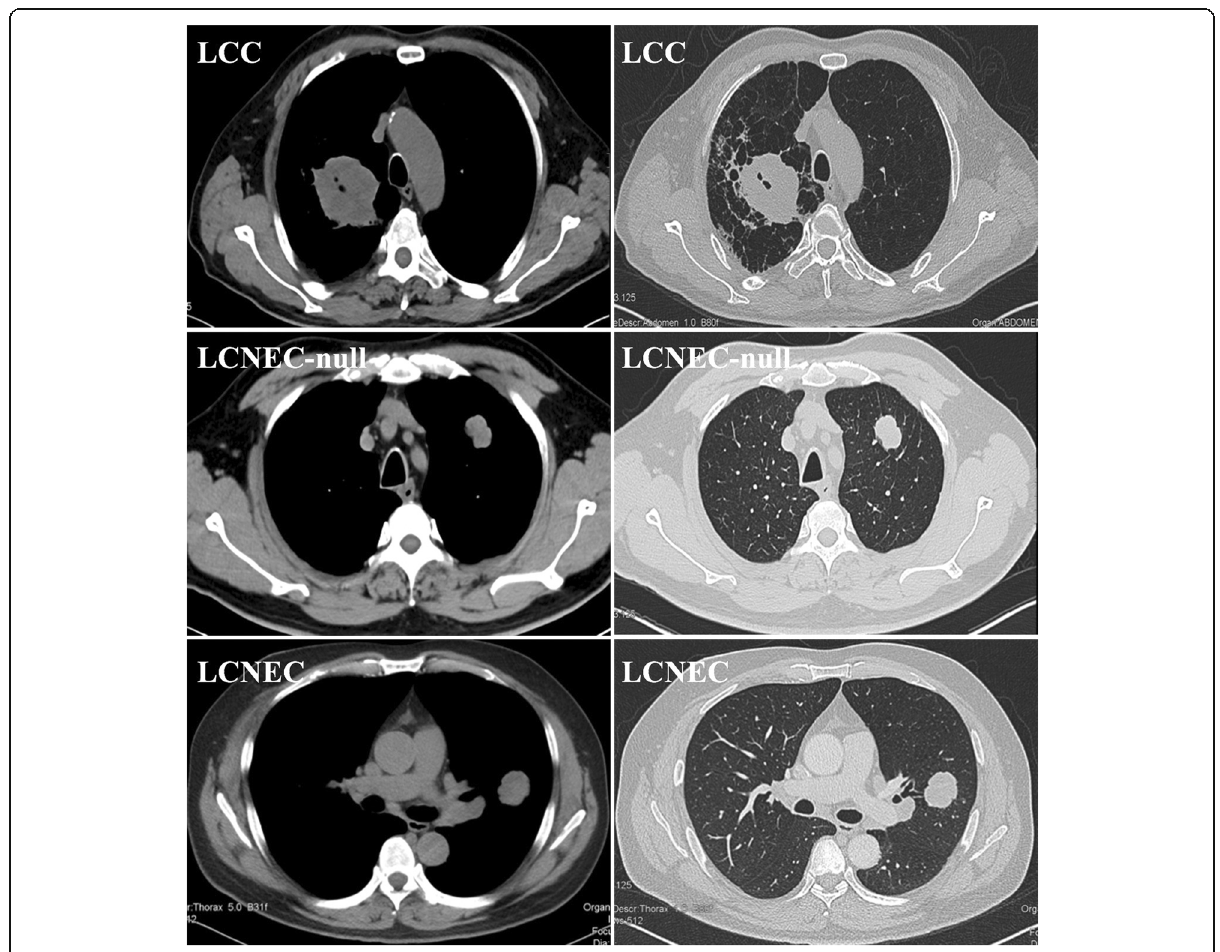
Fig. 1 MSCT (Multi-slice computed tomography) of 3 typical cases of each group. A centrally irregular huge mass can be easily found in most LCCs, followed by signs of airway obstruction. By contrast, LCNEC-nulls and LCNECs always show a nodular shadow with lobulated margin in